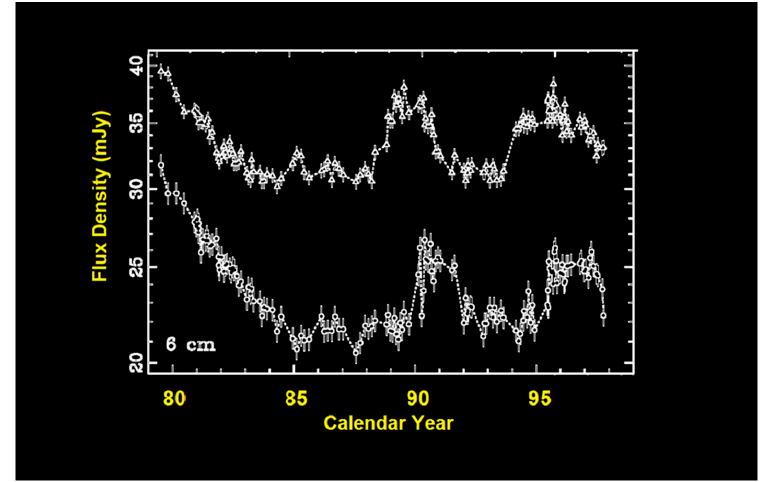
Figure 20. Monthly observations from 1979 to 1997 at 6 cm wavelength of the flux densities of the two images of quasar 0957+561 using the Very Large Array radio telescope (VLA) (After [114]). Fitting for the time delay between the images produced a value of 409 ± 30 days consistent with that obtained previously with optical wavelengths.